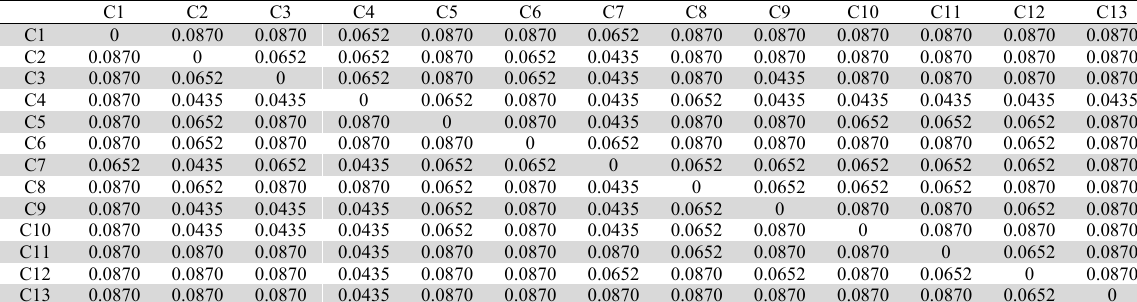
Total-relation fuzzy matrix (y)